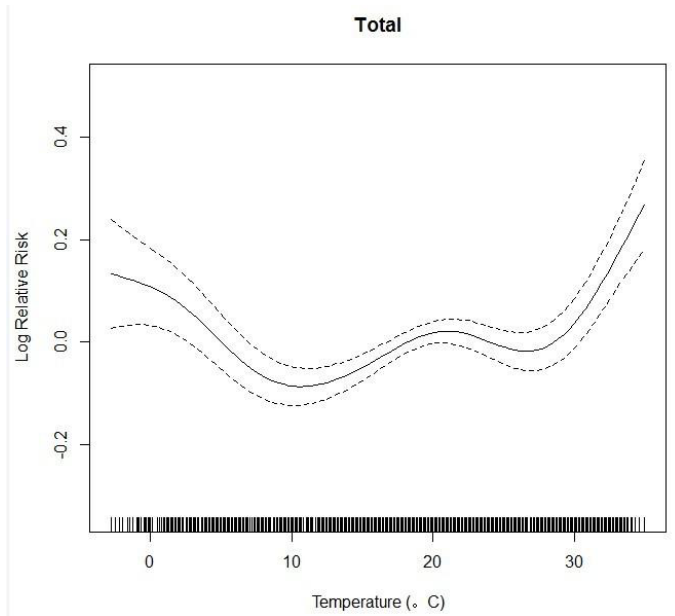
Figure 3. The Association Curve between Log Relative Risk and